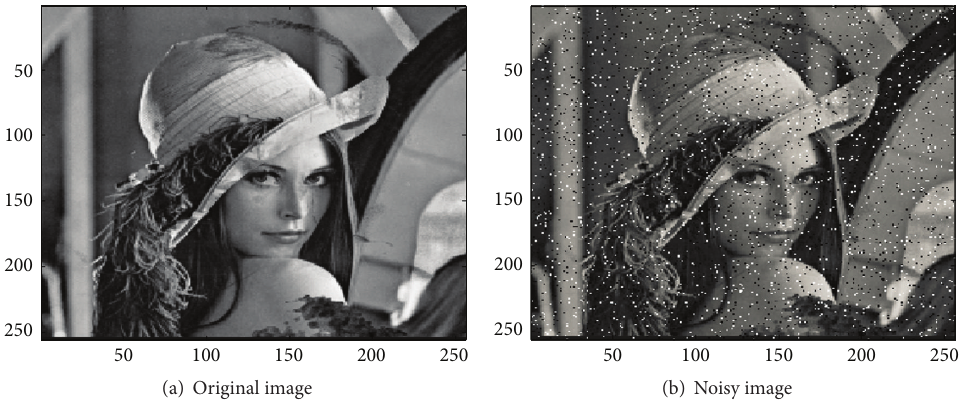
Figure 4: Gray Lean image and its contaminated version by salt and pepper